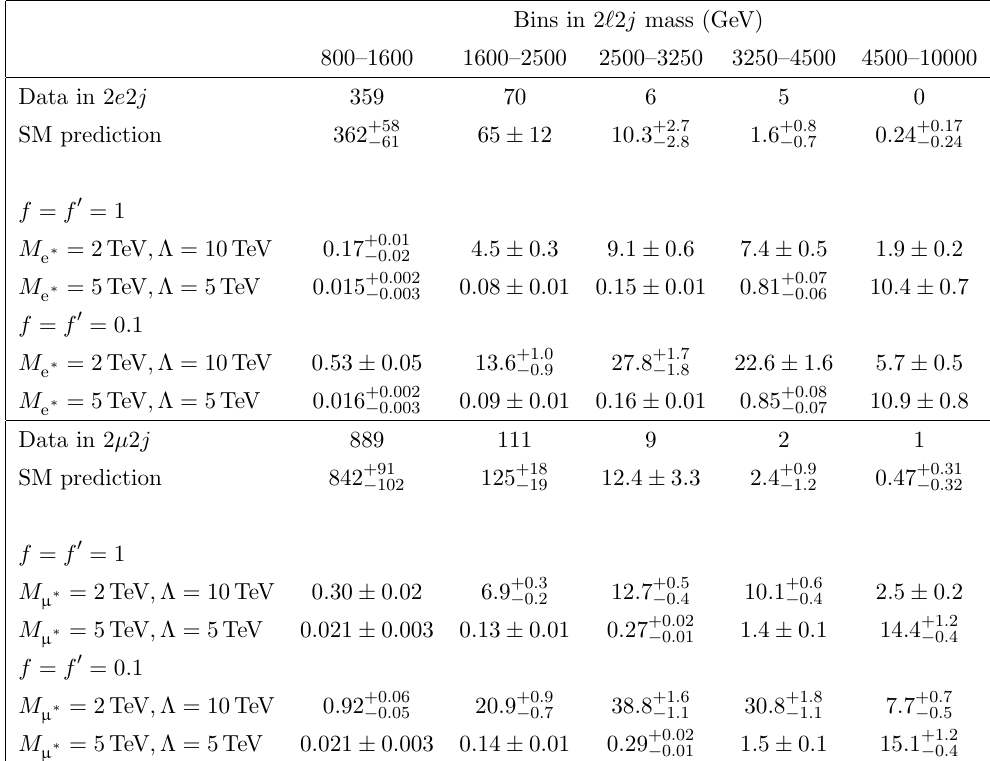
Table 1 . Observed event yields in bins of four-body mass compared to the expected SM background, for the 2 e 2 j and 2 (cid:22) 2 j (cid:12)nal states. Also shown are the expected event yields for two simulated signal samples with the given masses and couplings. All yields are given in bins of the discriminating four-body mass (2 ‘ 2 j ) distribution, with lower and upper value for each bin given in units of GeV. Systematic uncertainties, as described in the text, are